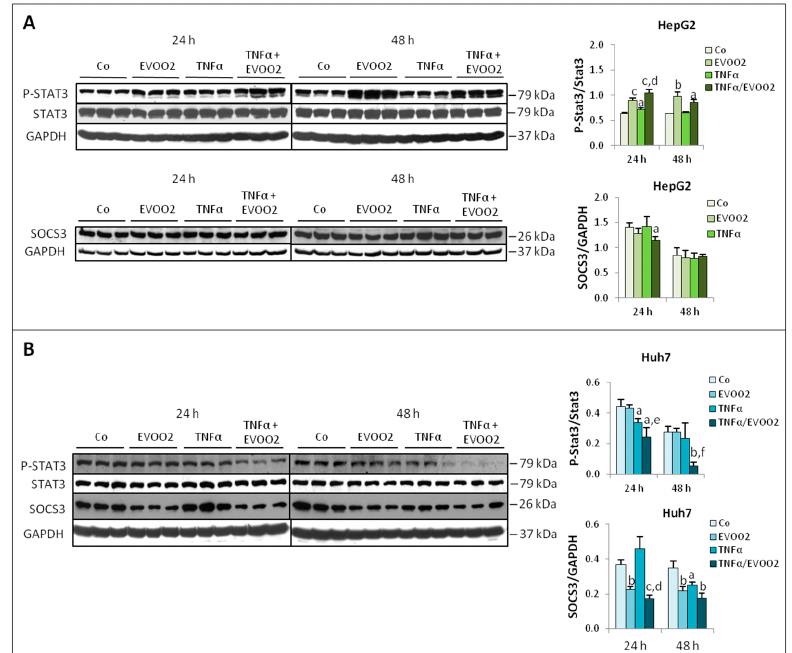
Figure 10. The combined treatment of EVOO and TNF α modulates the expression of P-STAT3 and SOCS3. The cell lines were incubated for 24 and 48 h with EVOO2 extract in the presence or absence of TNF α . ( A ) Western blot analysis of P-STAT3 and SOCS3 in HepG2 cell. ( B ) Expression of P-STAT3 and SOCS3 in Huh7 cell line. The results are representative of three experiments. The protein molecular weights are reported. Data are presented as mean ± SD. (a: p < 0.05, b: p < 0.01, c: p < 0.001 versus Control; d: p < 0.05, e: p < 0.01, f: p < 0.001 versus